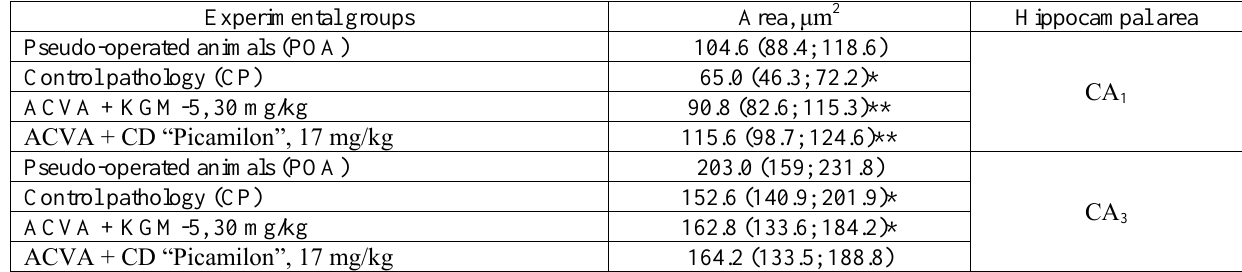
and CA zones of the ventral hippocampus of rats 1 3